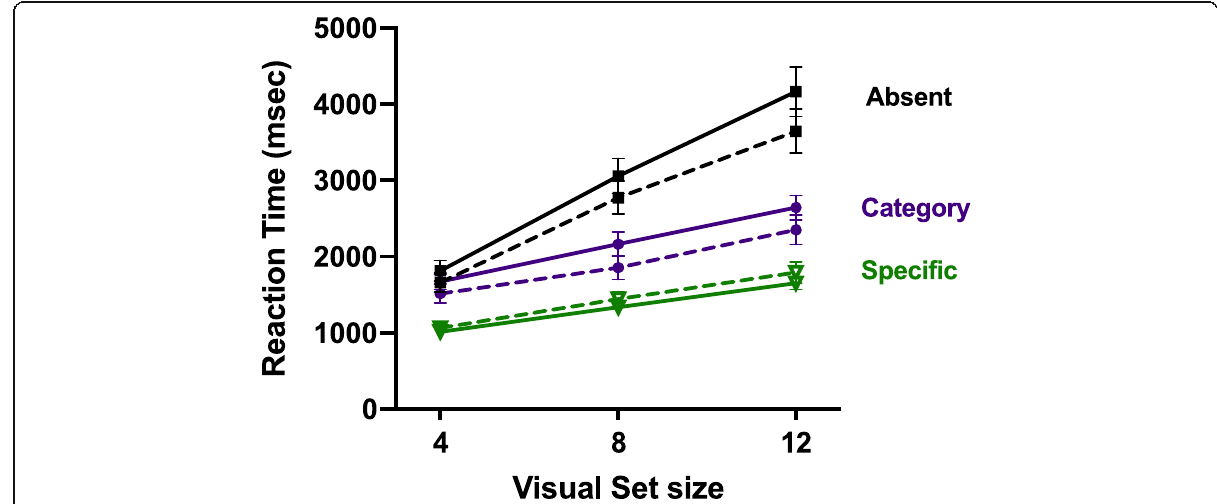
Fig. 2 Solid lines show the reaction time (RT) x visual set size functions for the non-boosted trials in Experiment 1a, averaged across the 3 blocks. For comparison, dotted lines show data from the 20/80 condition of Experiment 2 in Wolfe et al. (2017). Error bars are ± 1 SEM